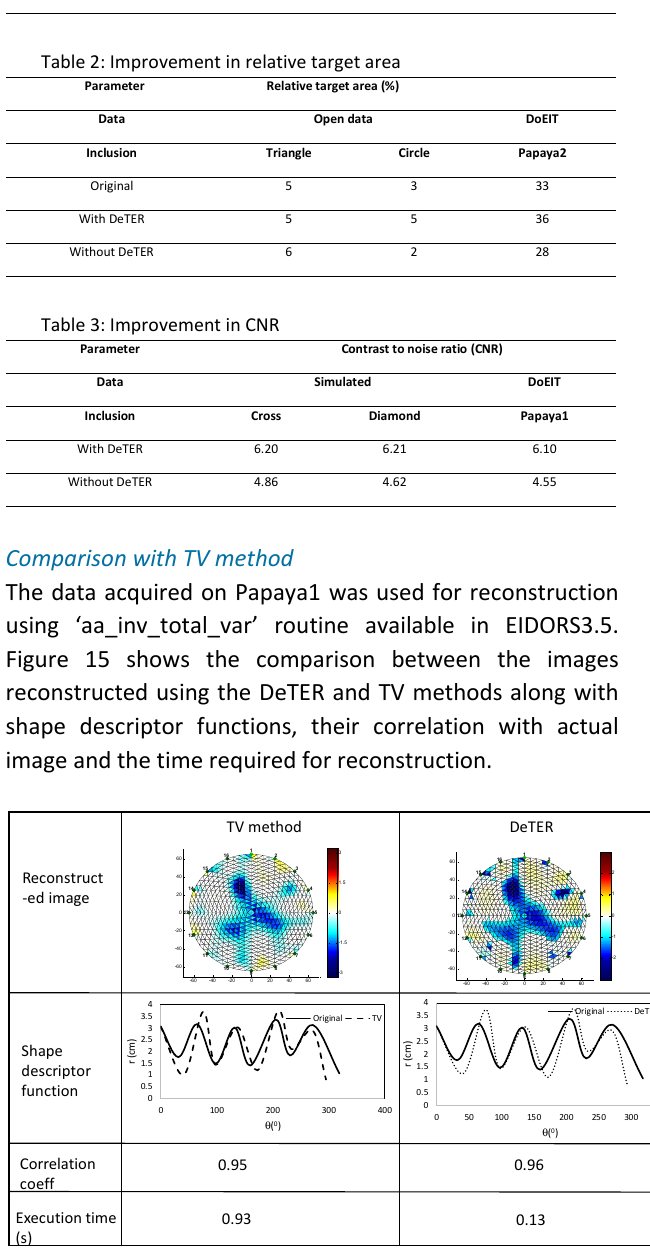
Fig.15: Comparison of DeTER with the TV